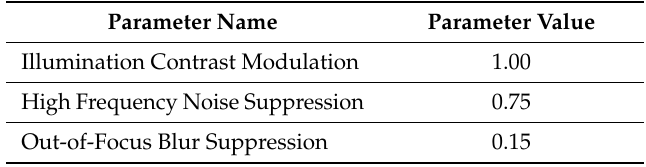
Table 1. N-SIM Reconstruction Parameters for Lamin Intermediate